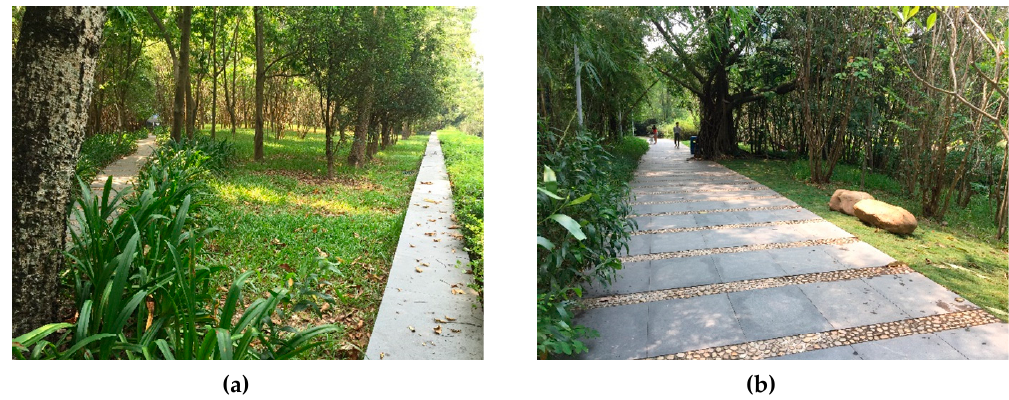
Figure 4. Photo showing a walking path crossing densely covered woodlands. ( a ) Narrow walking path without visitors; ( b ) Wide walking path with few visitors.